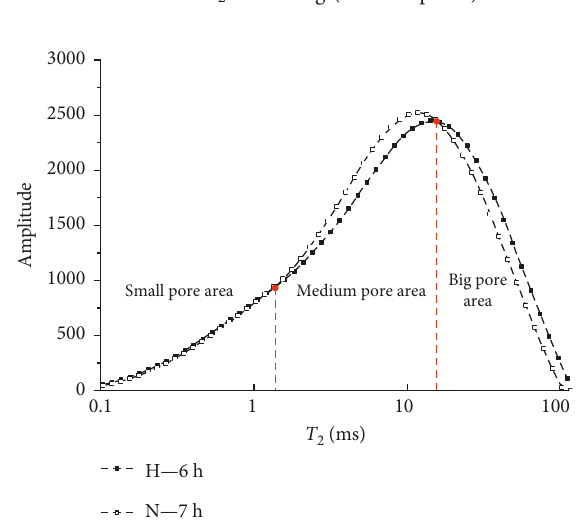
2 O and (NH 4 ) 2 SO 4 (the second